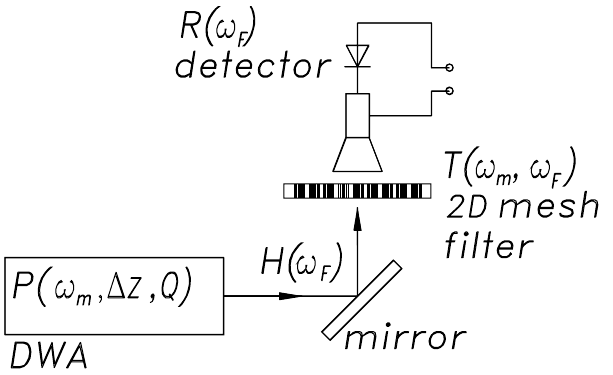
8. Schematics of power transmission from the DWA to the detector through a narrow bandwidth filter, and the over- moded beam transport pipe.